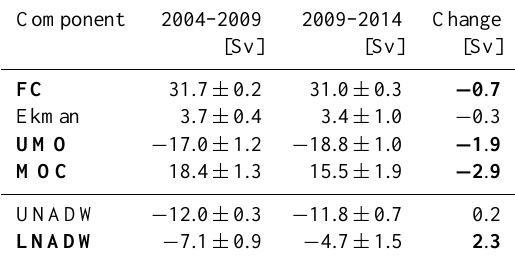
Figure 2. (a) Transport time series of the FC (blue), Ekman (green), upper mid-ocean (magenta), and overturning (red) at 10-day reso- lution. (b) Layer transports for UNADW (1100–3000m, cyan) and LNADW (3000–5000m, purple). For visualization purposes, the fil- tered versions of the time series are shown in black, where trans- ports have been convolved with a 4-month, low-pass Hanning win- dow. Transports are positive northwards; 10-year mean transports for each components are shown with the dotted lines.